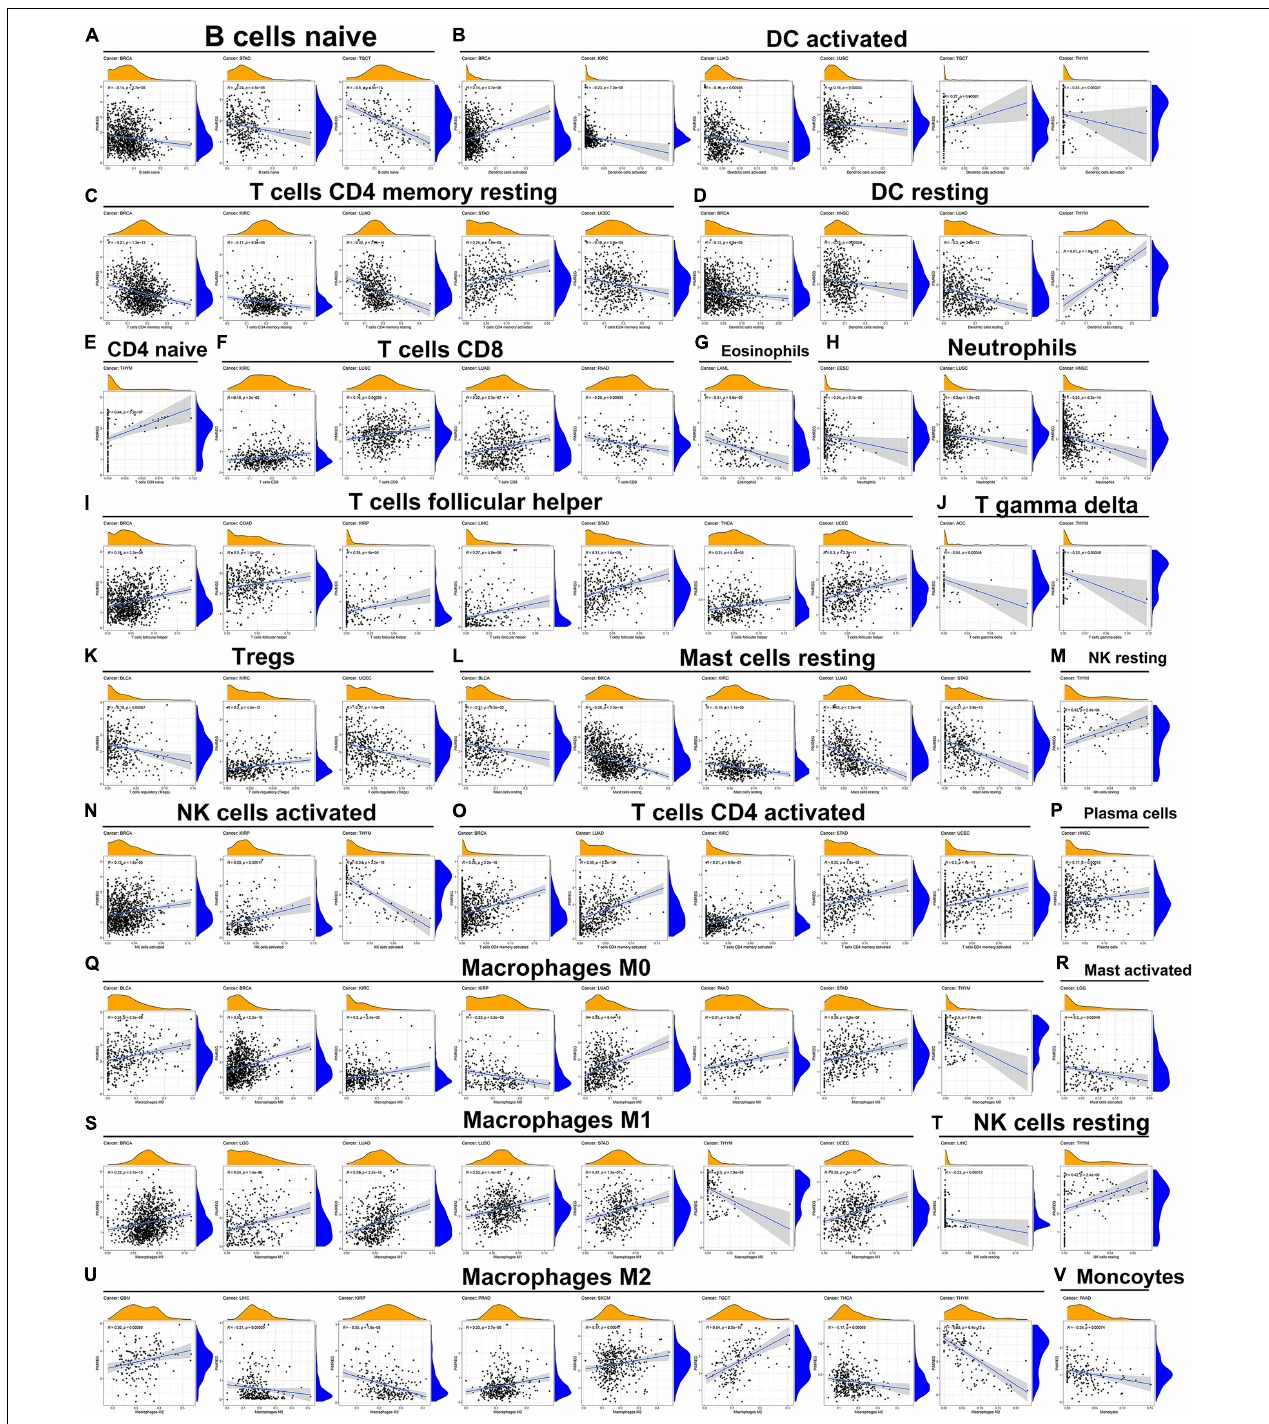
FIGURE 12 | Association of PIMREG expression with infiltration levels of different immune cells in various cancers. Correlation of PIMREG with (A) naïve B cells, (B) activated DC cells, (C) resting memory CD4 T cells, (D) resting DC cells, (E) naïve CD4 T cells, (F) CD8 T cells, (G) eosinophils, (H) neutrophils, (I) T cells follicular helper, (J) gamma delta T cells, (K) Tregs, (L) resting mast cells, (M) resting NK cells, (N) activated NK cells, (O) activated CD4 T cells, (P) plasma cells, (Q) macrophage M0, (R) activated mast cells, (S) macrophage M1, (T) resting NK cells, (U) macrophage M2, and (V) monocytes in various cancers.